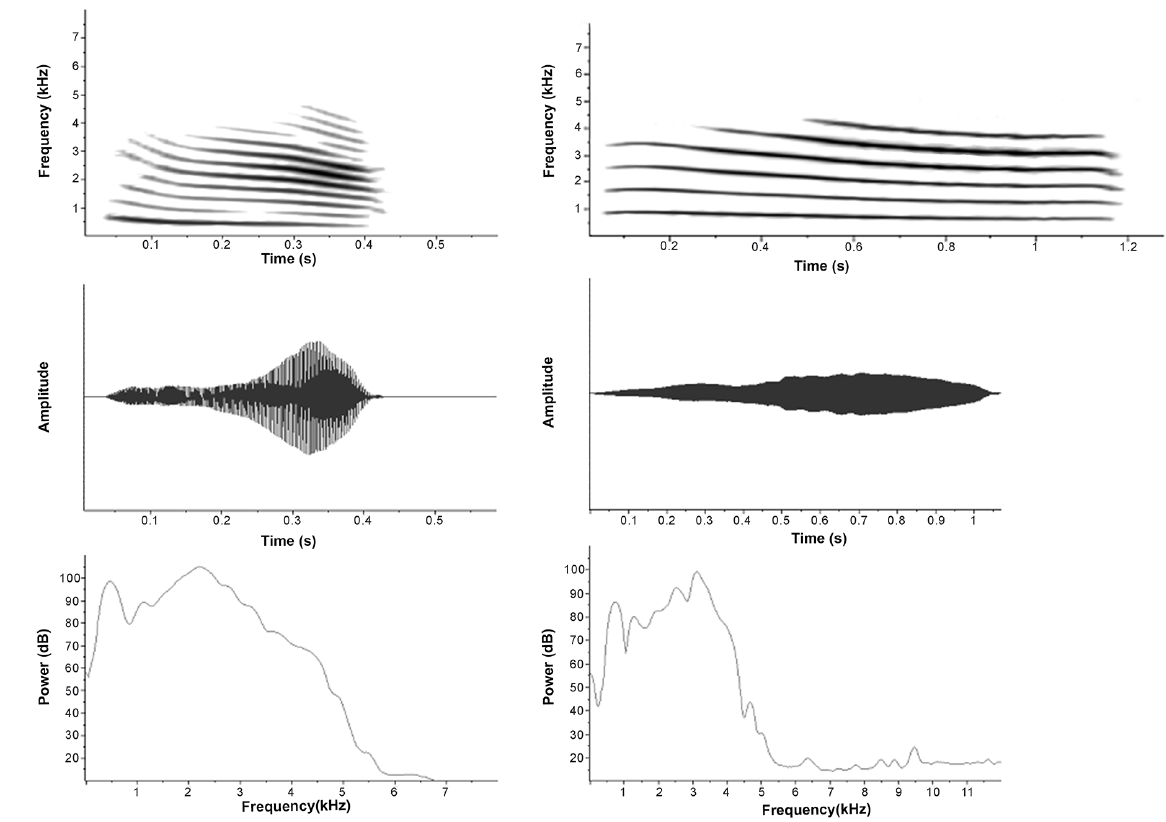
Figure 3. Advertisement calls of P. santafecinus (left) and P. aff. albonotatus (right) with spectrograms (upper), oscillograms (middle), and power spectrum